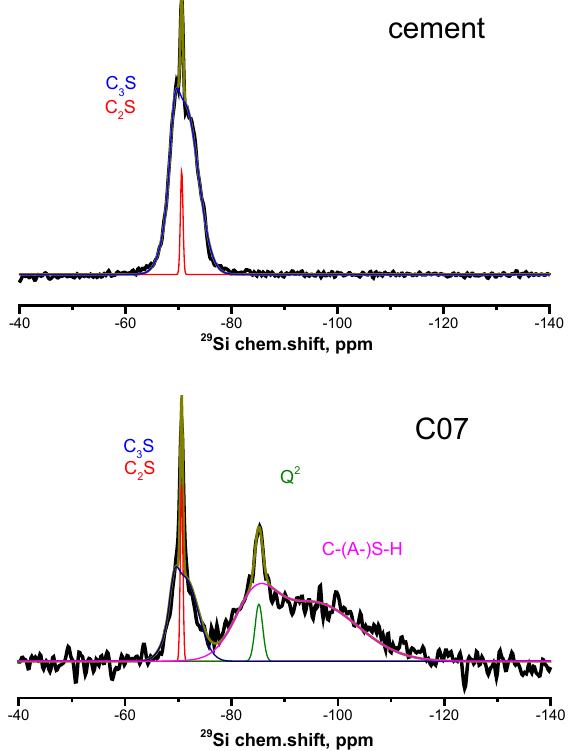
Figure 3. 29 Si NMR spectra of the ( top ) anhydrated Portland-limestone cement, and ( bottom ) cement paste sample without additives at the 7th day of hydration.